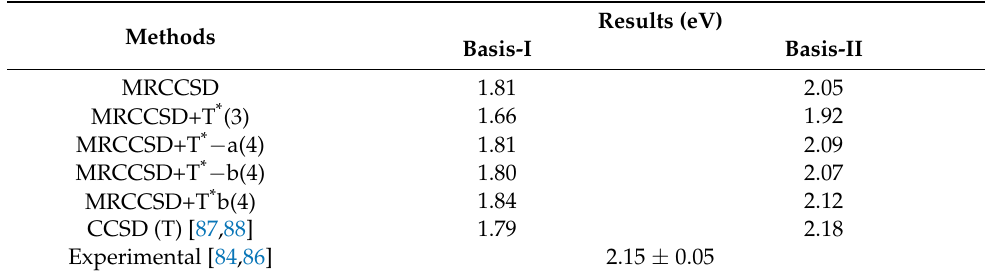
Table 6. Vertical electron affinity of BeO using various basis sets at inter-nuclear separation of 2.515 a. u.